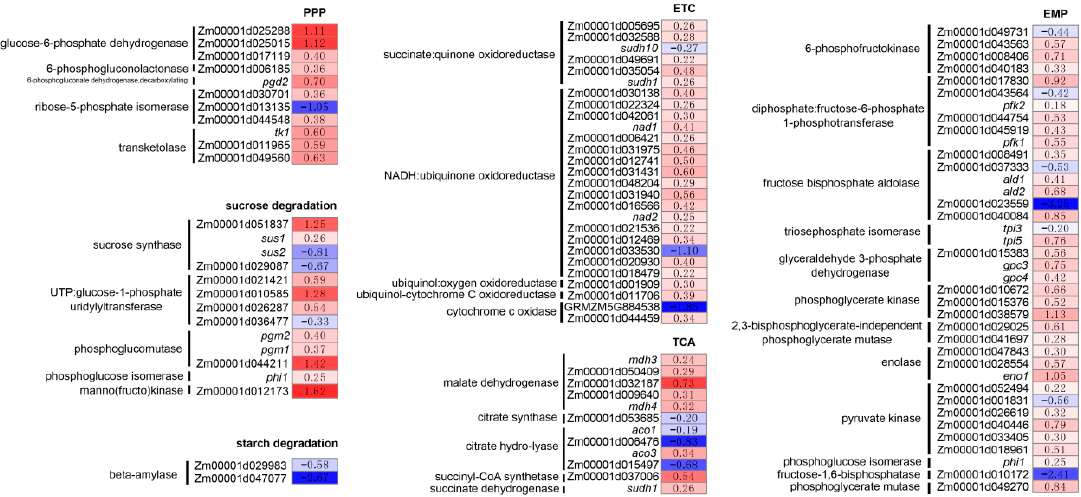
Figure 3. Pathway analysis of the DEGs involved in carbohydrate catabolism and the electron transport chain. The data and the color of the rectangles indicates mean log 2 (fold change) of the DEGs; plant metabolic pathway databases [29] were used for pathway analysis described above from left to right: Pentose phosphate pathway (PPP), sucrose degradation, starch degradation, Electron Transport Chain (ETC), Tricarboxylic Acid Cycle (TCA) and the Embden–Meyerhof–Parnas pathway (EMP).